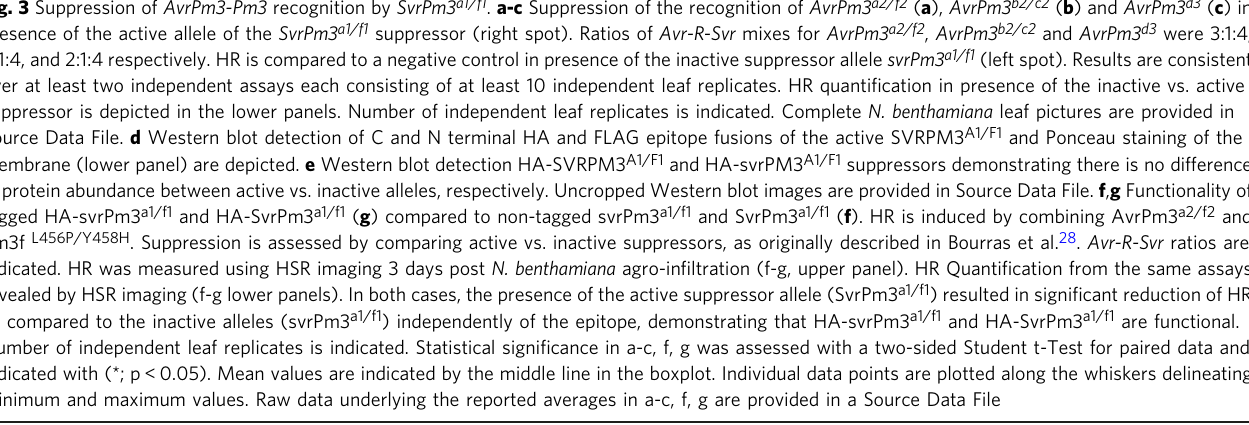
Fig. 3 Suppression of AvrPm3-Pm3 recognition by SvrPm3 a1/f1 . a-c Suppression of the recognition of AvrPm3 a2/f2 ( a ), AvrPm3 b2/c2 ( b ) and AvrPm3 d3 ( c ) in presence of the active allele of the SvrPm3 a1/f1 suppressor (right spot). Ratios of Avr-R-Svr mixes for AvrPm3 a2/f2 , AvrPm3 b2/c2 and AvrPm3 d3 were 3:1:4, 4:1:4, and 2:1:4 respectively. HR is compared to a negative control in presence of the inactive suppressor allele svrPm3 a1/f1 (left spot). Results are